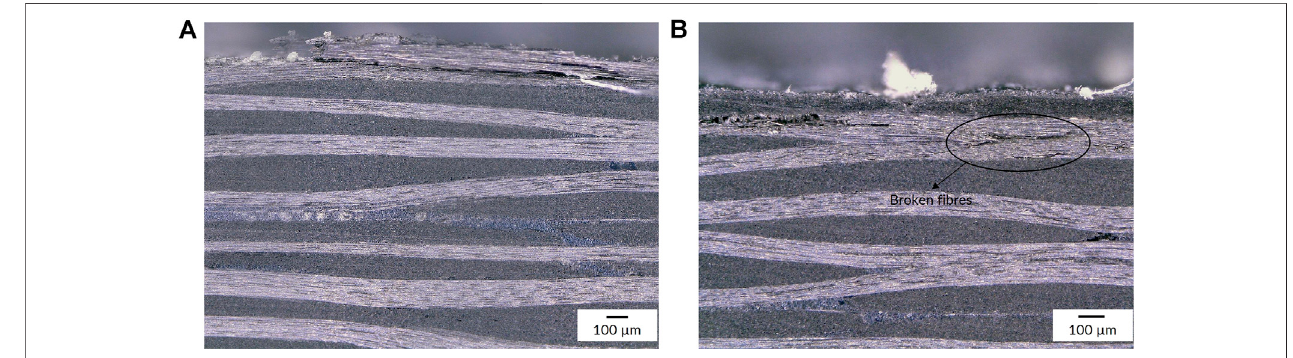
FIGURE 9 | Optical microscopy images of the cross-section of D2 [(0/90)] 18 samples, clearly displaying some broken fi bers, on the top ply (A) and internal ply (B) .